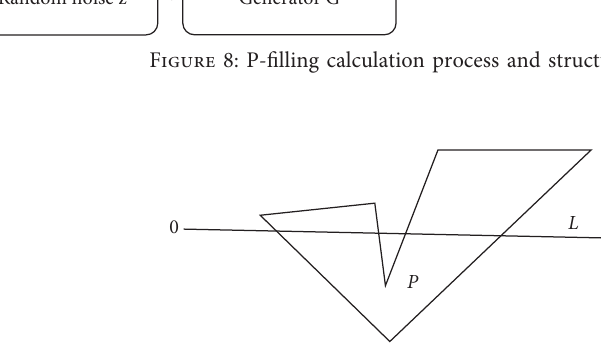
Figure 9: Continuous iterative algorithm is most suitable for undamaged image creation.